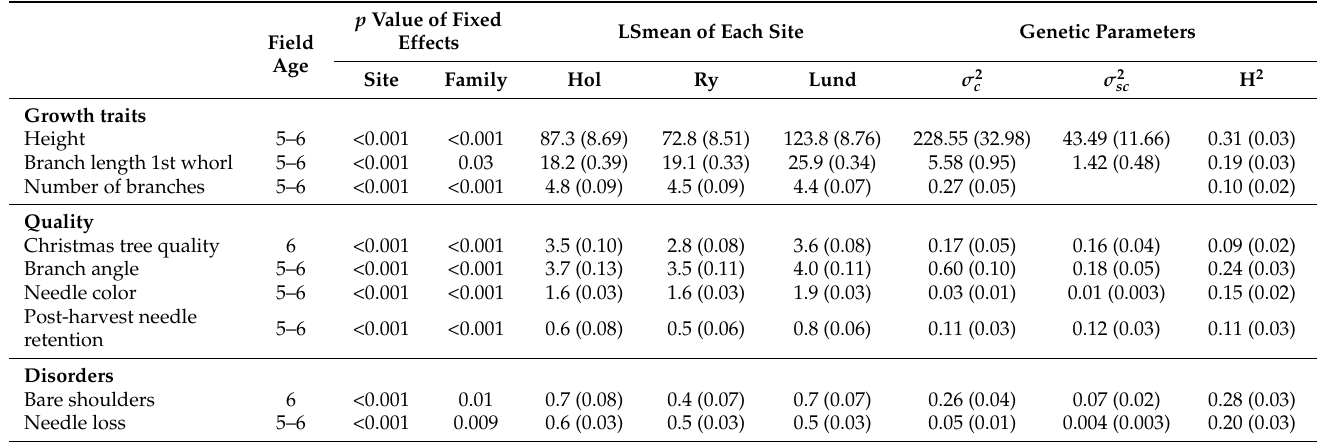
Figure 4. ( A ): Mean height between somatic embryogenesis (SE) and zygotic seedlings (seedling) from 2016 to 2020 at Lundbygaard and Ry; ( B ): Mean increment growth between SE and seedlings from 2017 to 2020 at Lundbygaard and Ry. Table 3. LSmean and genetic parameters for multi-sites analysis of all studied